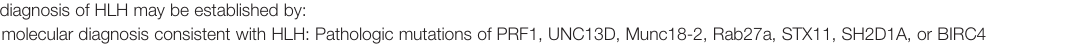
TABLE 2 | Diagnosing HLH with A and B, respectively. A: Diagnostic criteria for HLH according to the conduct of the HLH-2004 trial The diagnosis of HLH may be established by: a. A molecular diagnosis consistent with HLH: Pathologic mutations of PRF1, UNC13D, Munc18-2, Rab27a, STX11, SH2D1A, or BIRC4 OR: b. Five out of the eight criteria listed below are ful fi lled: